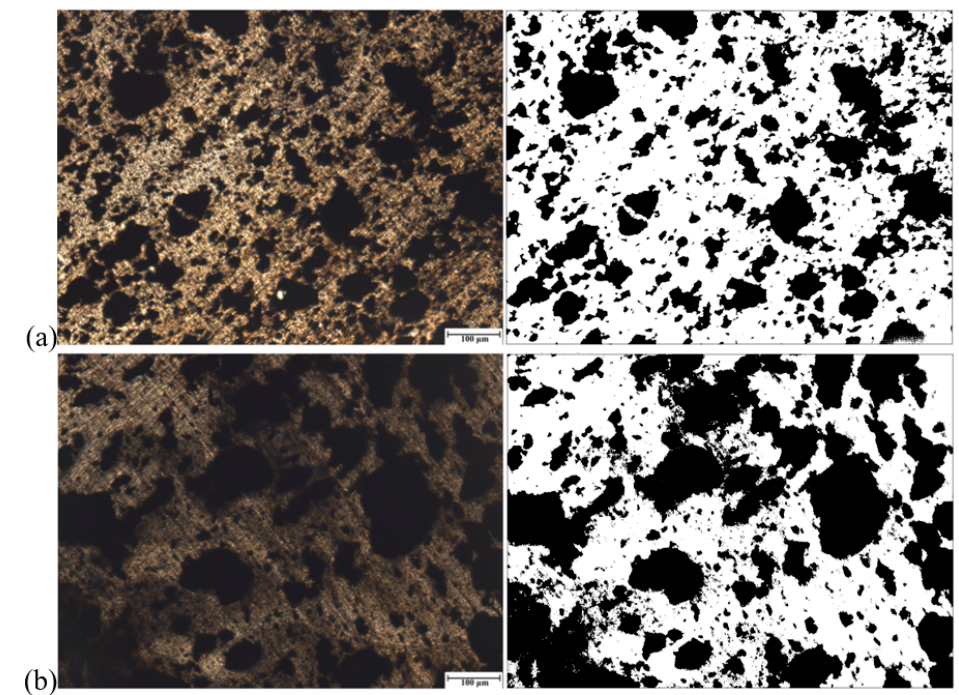
Figure 18. Optical micrographs of PP/EPDM 75/25 blends without ( a ) and with ultrasonic treatment at an amplitude of 13 µ m ( b ) prepared by the TS method (right micrographs were treated by the ImageJ software).